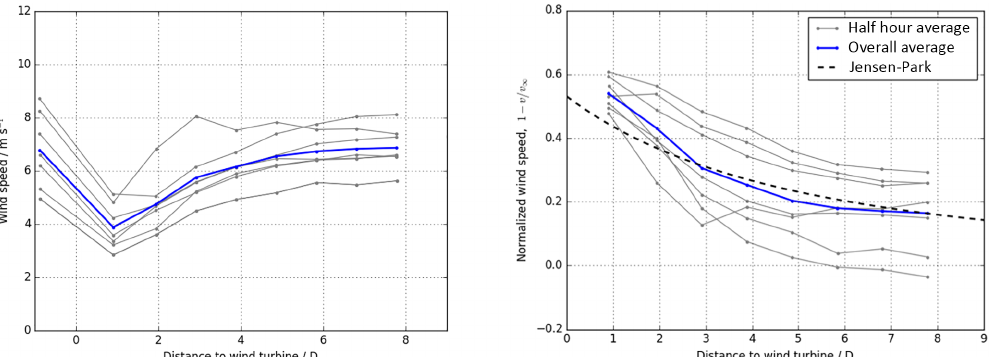
Figure 9. Multi-Doppler wind speed measurements plotted against distance to the turbine (a) , and wind speed deficit normalized to a measurement point 1 rotor diameter upstream (b) on 2 June